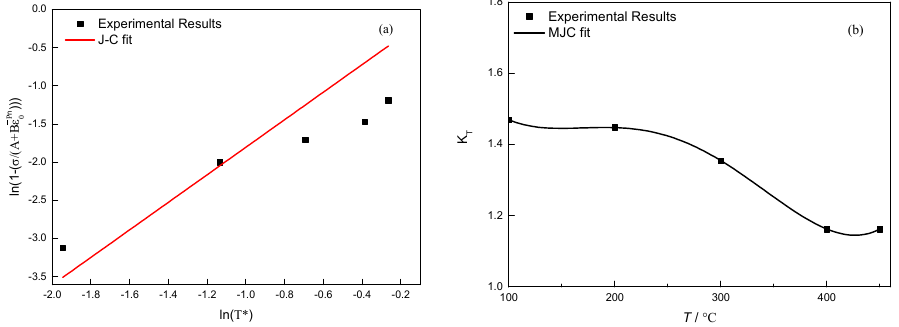
n )) at 2000 s − 1 . ( b ) The relation between Pn A B σ ε− + 0 at 2000 s ‒ 1 . ( b ) The relation